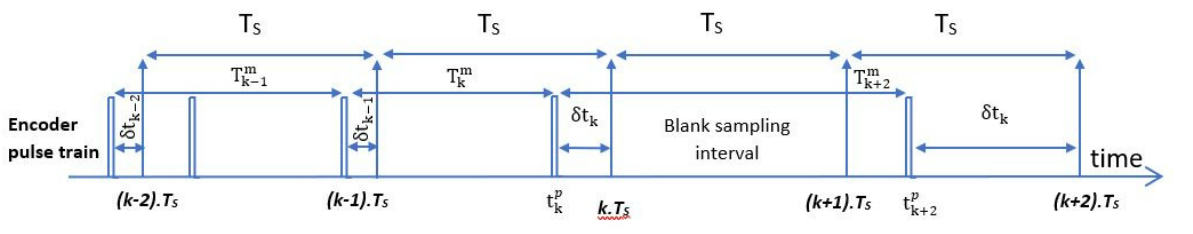
Figure 3. Sampling intervals for speed